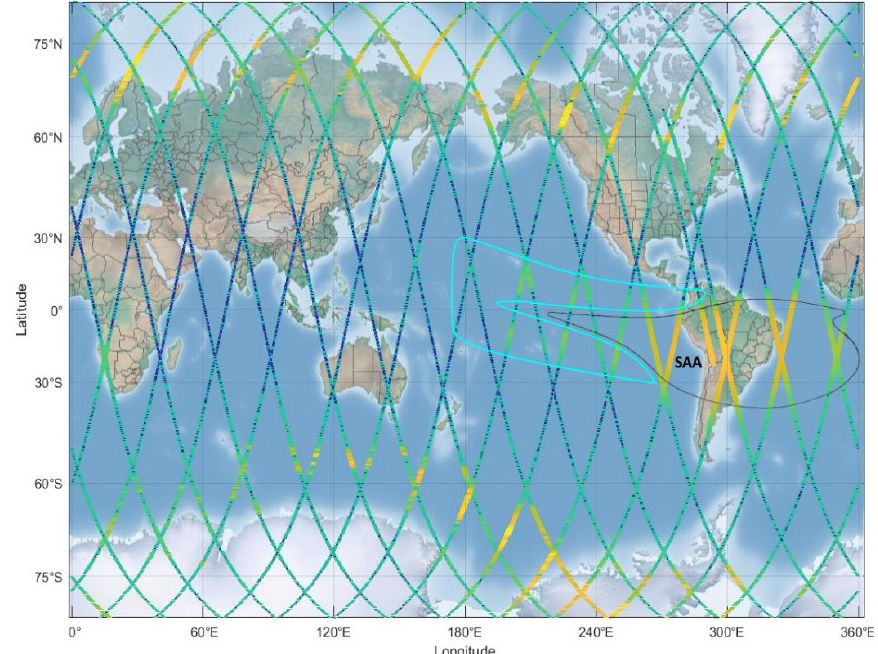
Figure 1. The set of NOAA-15 semi-orbits on 4 January 2001, with the CRs along the line orbits evidenced by colors; CR = 0 in blue, CR = 10 0 in light blue, CR = 10 1 in green, CR = 10 2 in orange, and CR = 10 3 in yellow; the SAA region is evidenced using a black contour, while the region where the satellite detect electrons in the loss cone, is evidenced by a cyan contour.